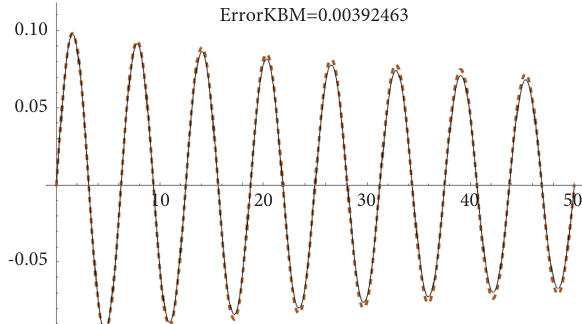
Figure 3: KBM-error comparison with the Runge–Kutta numerical solution.